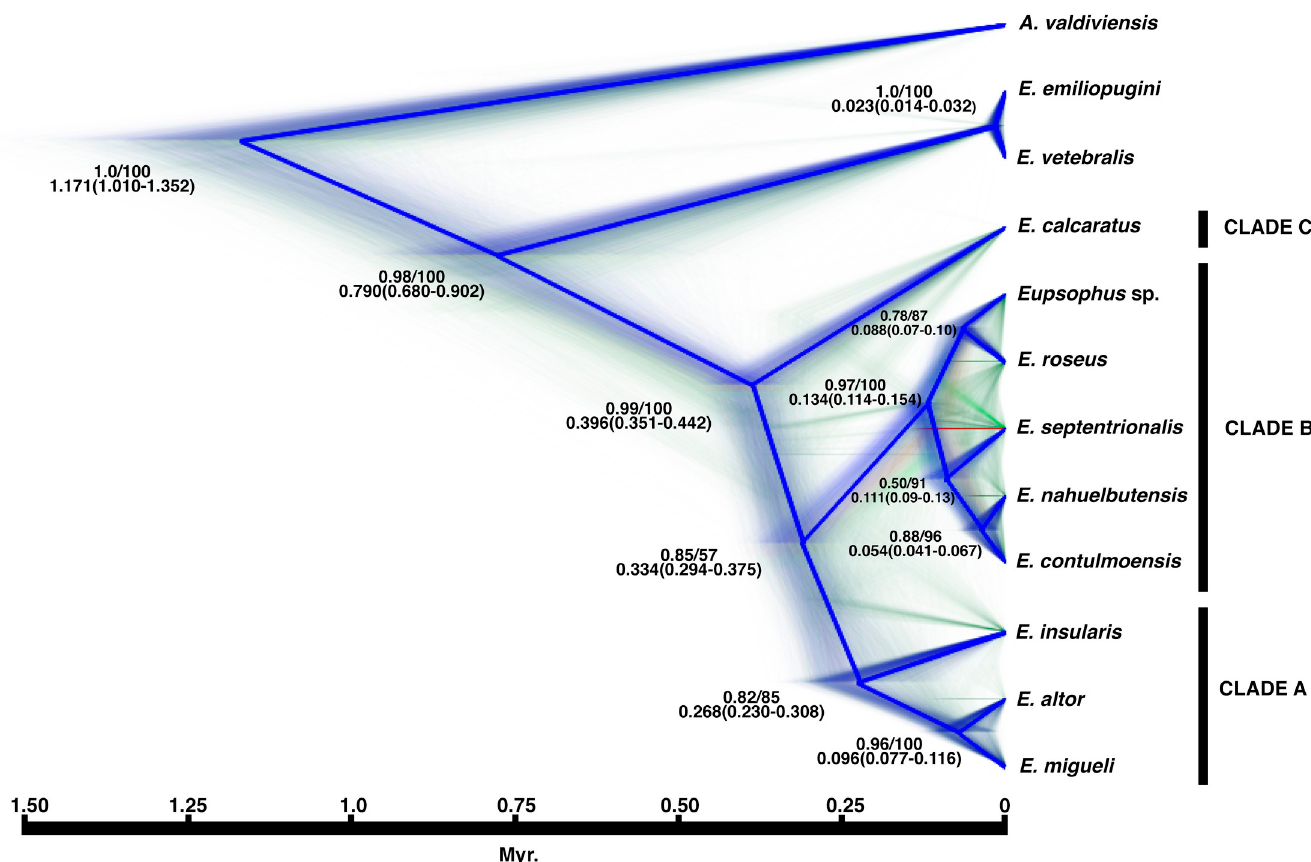
Fig 5. Species tree and divergence times of Eupsophus . This cladogram illustrates the posterior distribution of the species trees inferred with BEAST based on the most congruent species delimitation scenario (Figs 3 and 4, S2 Table). High color density is indicative of areas in the species trees with high topology agreement. Different colors represent different topologies. Consensus species tree are colored in blue. Nodal values are Bayesian posterior probability (BEAST) and bootstrap proportions (SVDquartets). Mean divergence dates in million years and 95% credible intervals are indicated (below the support